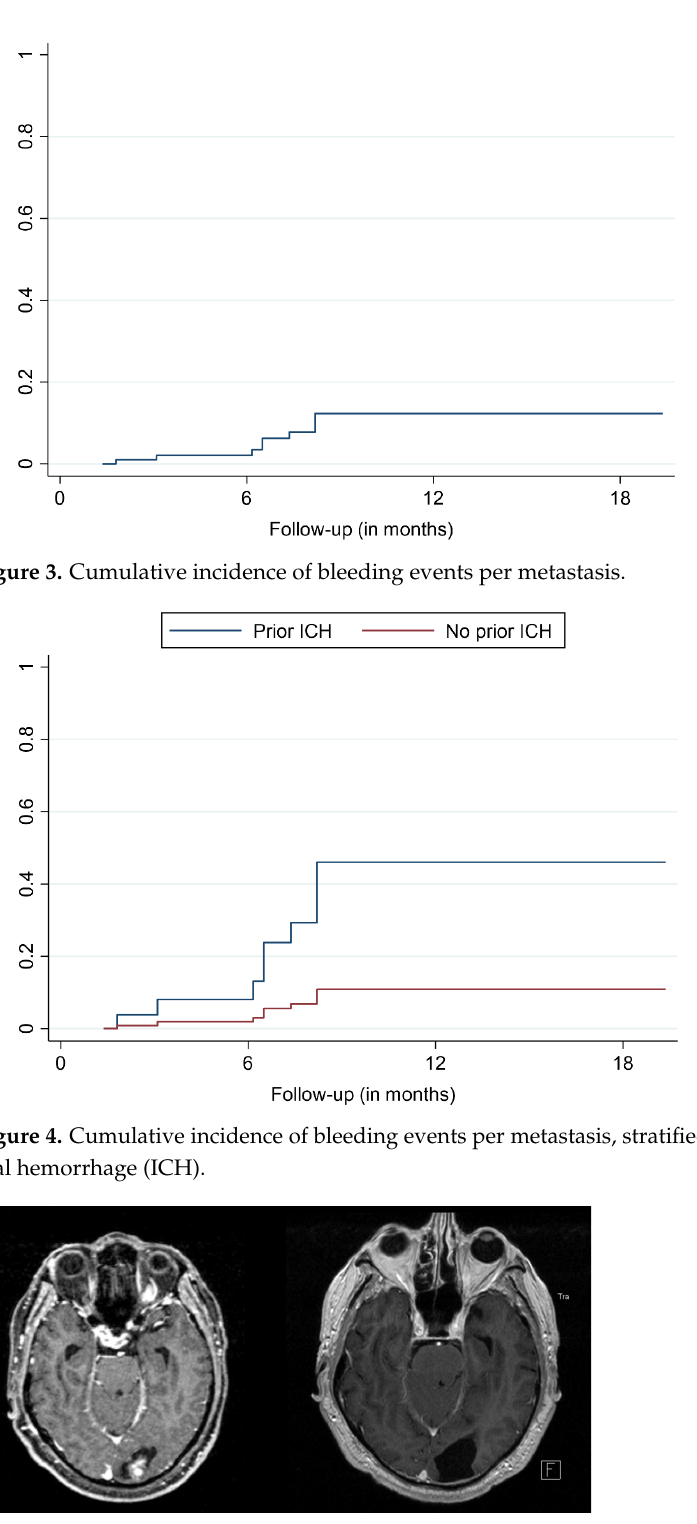
Figure 5. Contrast-enhanced magnetic resonance imaging (MRI) scans in the axial plane of a 72- year-old man suffering from a metastasized malignant melanoma. He underwent stereotactic